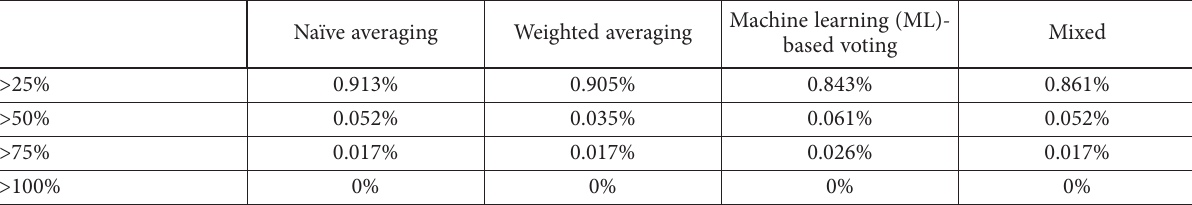
Table 13. Right-tail probability of absolute percentage error: combined